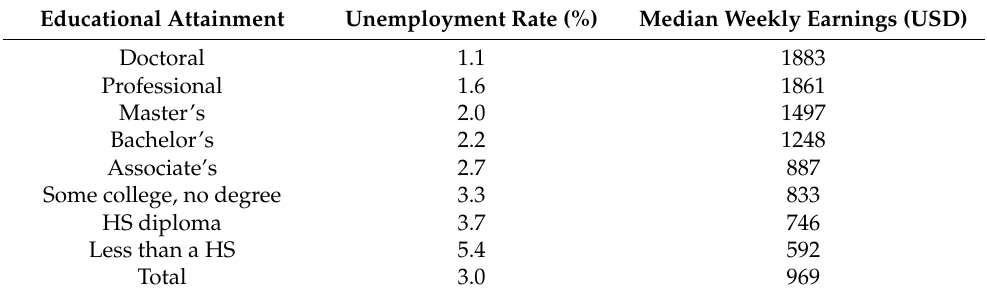
Table 1. Unemployment Rate (%) and Median Weekly Earnings (USD) by Educational Attainment.